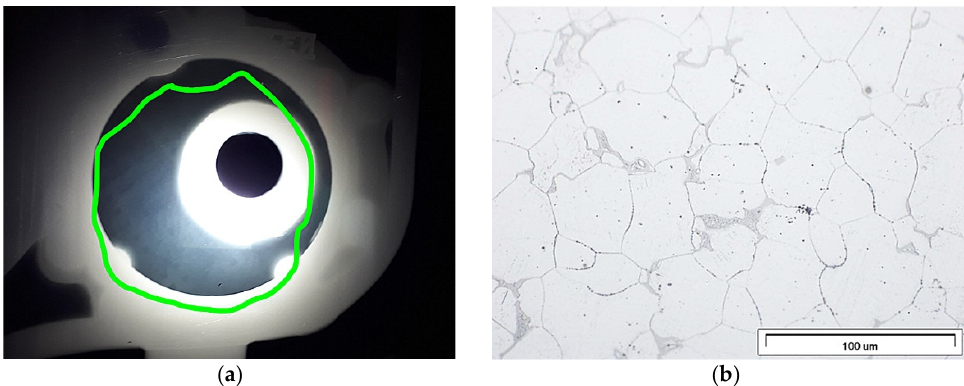
Figure 22. Stage 5 Casting critical areas: ( a ) XRD results; ( b ) low porosity (LM).